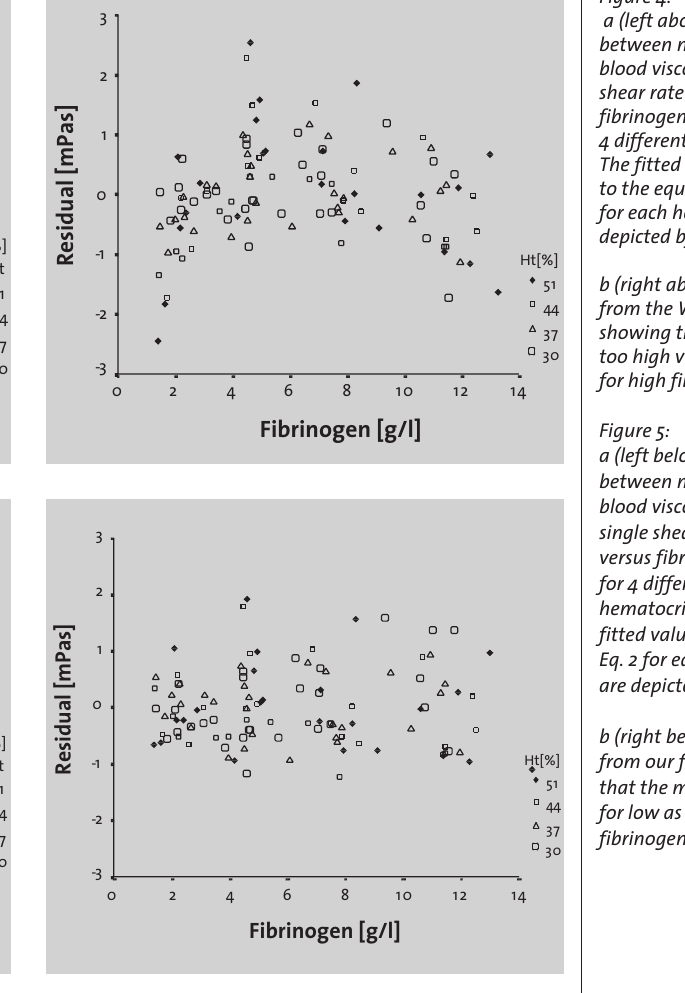
Figure 4: a (left above): Relation between measured whole blood viscosity at the single shear rate 4.04 sec-1 versus fibrinogen level [g/l] for 4 different hematocrits [%]. The fitted values according to the equation of Walburn for each hematocrit are depicted by “+”. b (right above): Residuals from the Walburn equation showing that the model fits too high values for low and for high fibrinogen levels. Figure 5: a (left below): Relation between measured whole blood viscosity at the single shear rate 4.04 s -1 versus fibrinogen level [g/l] for 4 different hematocrits [%]. The fitted values according to Eq. 2 for each hematocrit are depicted by “+”. b (right below): Residuals from our formula show that the model fits good for low as well as for high fibrinogen